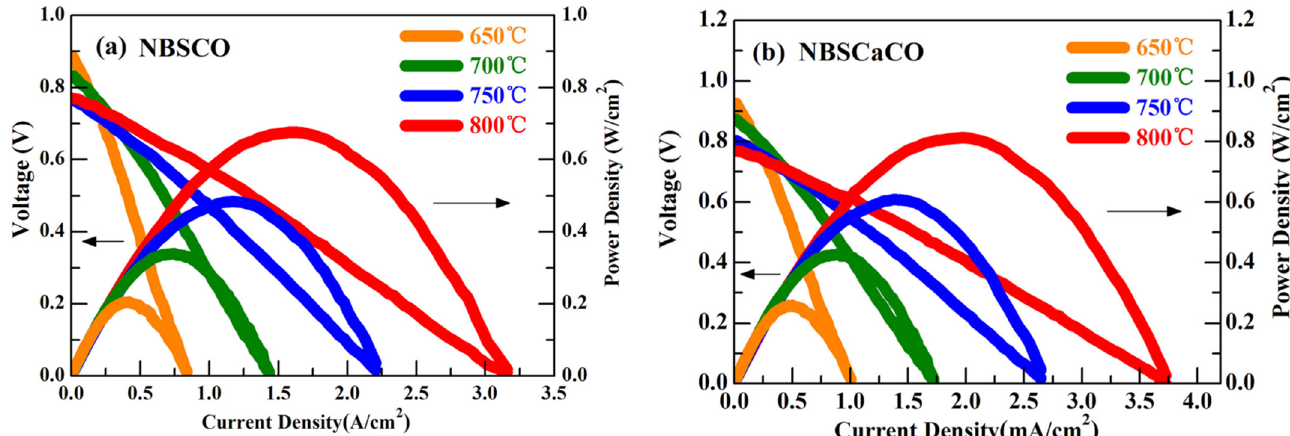
Figure 7. I – V curves and corresponding output power density of ( a ) NiO–SDC|SDC|NdBa 0.5 Sr 0.5 Co 2 O 5+ δ –SDC and ( b ) NiO–SDC|SDC|NdBa 0.5 Sr 0.25 Ca 0.25 Co 2 O 5+ δ –SDC single cells at various temperatures (adopted with permission from [120]. Copyright 2018, Elsevier).